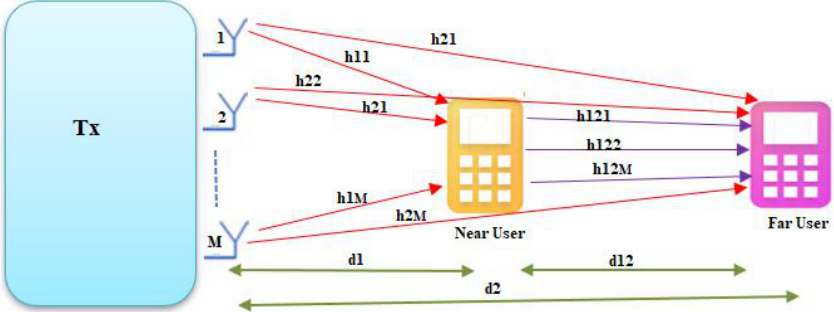
Figure 4. Downlink transmission for the cooperative NOMA network integrated with a 128 × 128, a 256 × 256, and a 512 × 512 MIMO.